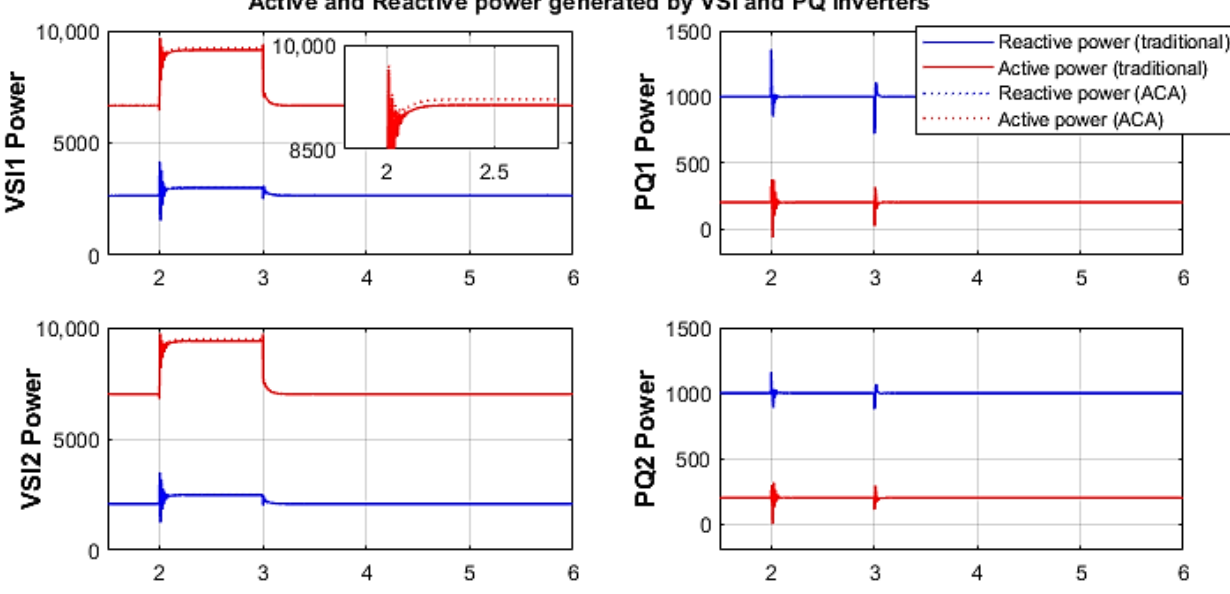
Figure 22. Active and Reactive Power Produced by Each Inverter.